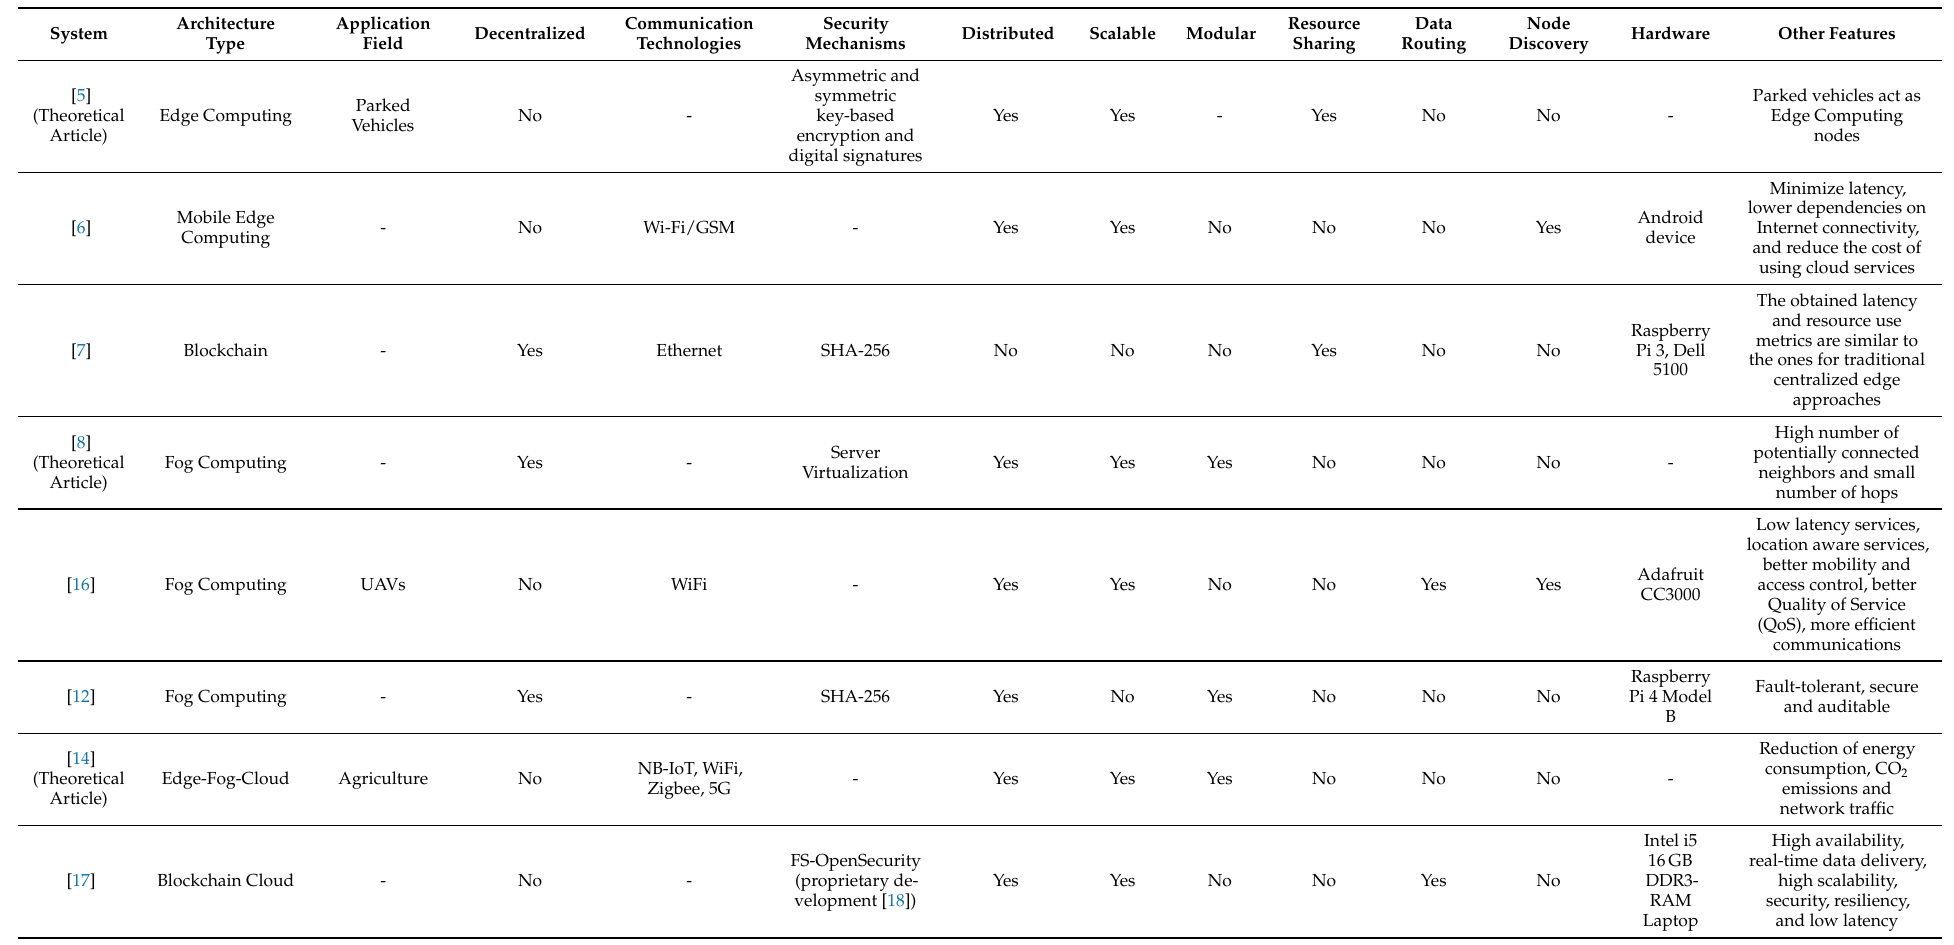
Table 1. Main characteristics of the most relevant theoretical and practical OEC